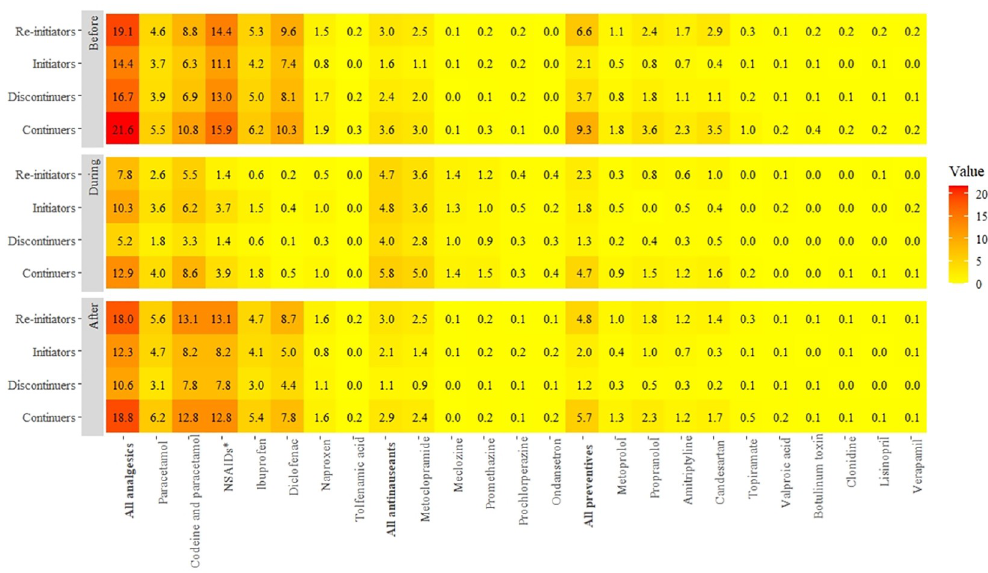
Fig 4. Heatmap illustrating the proportion of pregnancies with filled prescriptions for other drugs among exposure groups before, during, and after pregnancy, 2006–2017. The darkest color indicates the maximum proportion of prescription